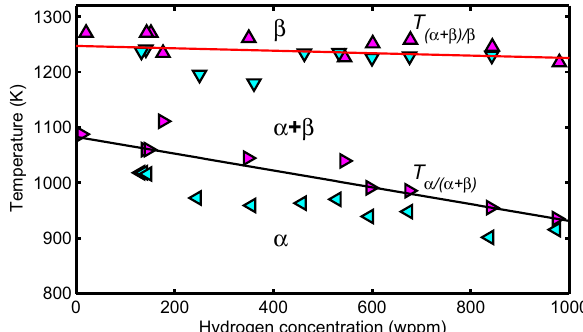
Figure 2. Phase boundary temperatures versus hydrogen concentration for Zircaloy-4L measured upon heating 0.17 K/s. The lines (between heating and cooling) are assumed to represent the ( ) and cooling ( ▽ ) at ≈ △ ⊲ ⊳ equilibrium temperatures; after Brachet et al. 20